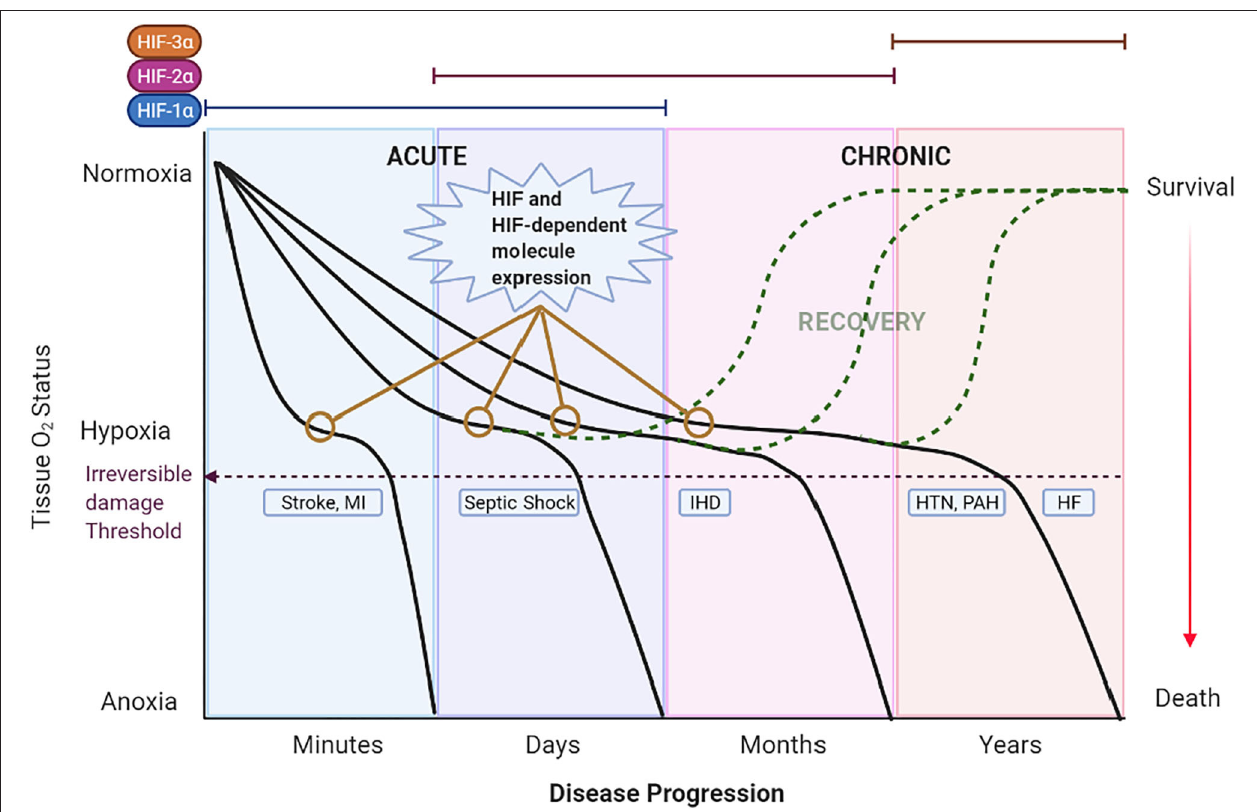
FIGURE 3 | Theoretical schematic representation of the temporal expression of HIFs and the impact of hypoxia in CV diseases across time. The left 2 panels show acute hypoxic states [i.e., Stroke, myocardial infarction (MI) and Septic Shock] lasting minutes to days. A rapid decrease in O 2 (first panel) induces severe hypoxia/anoxia and irreversible damage in minutes to hours leading to death or permanent disability (purple dashed line). The second panel represents septic shock as the hypoxic state that lasts days. Under these acute hypoxic states, HIF-1 α is stabilized, translocated to the nucleus and bound to HIF-1 β to form a dimer termed HIF-1. HIF-1 activates the transcription of multiple genes as an adaptation response. Eventually, HIF-1 α expression is switched to other HIFs; HIF-2 α and HIF-3 α in chronic hypoxic states. On the right 2 panels the chronic hypoxic states [i.e., Hypertension (HTN), Pulmonary Arterial Hypertension (PAH) and Heart Failure (HF)] are represented. Here, the sustained mild hypoxia induces long-term adaptive mechanisms triggered by HIFs that, ultimately, become detrimental and lead to death. Expression of HIF and HIF-dependent genes (represented by yellow lines with empty circles) are observed in the early stages of CV diseases. Detection of such genes at an opportune time might allow for the early treatment and recovery of the patient (dashed green